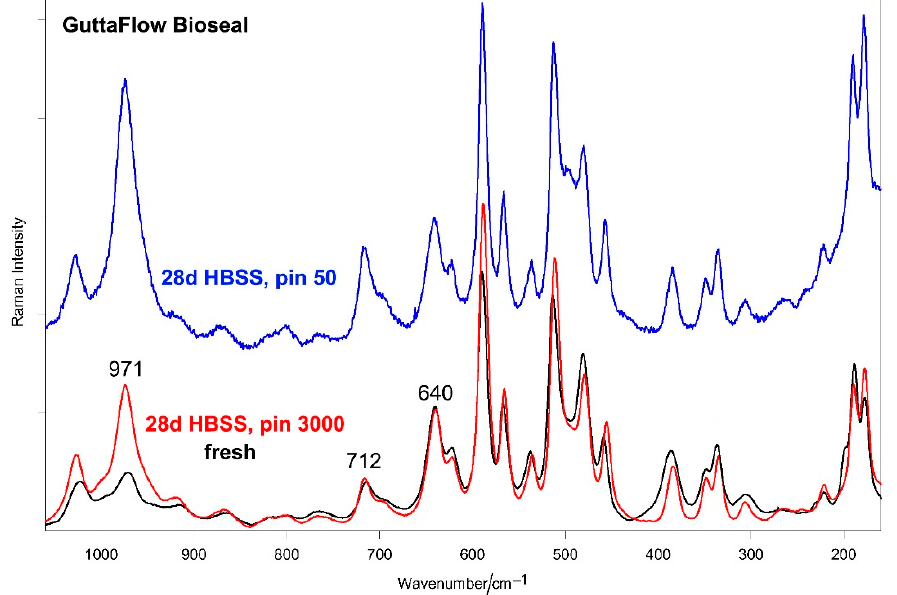
Figure 8. Average micro-Raman spectra recorded on the surface of GuttaFlow Bioseal before (i.e., fresh) and after aging in HBSS for 28 days. The spectra were normalized to the intensity of the 638 cm − 1 band. The spectra of the aged sample were recorded using pinholes of 3000 μ m (pin 3000) and 50 μ m (pin 50). The bands assignable to monoclinic zirconia (Z) and polydimethylsiloxane (pSi) are indicated.